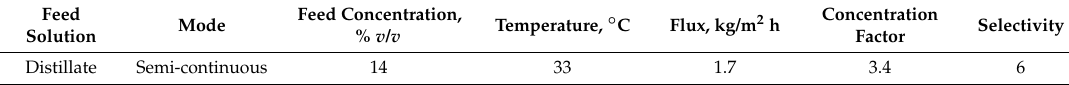
Table 4. Performance data of the recovery of ethanol from the